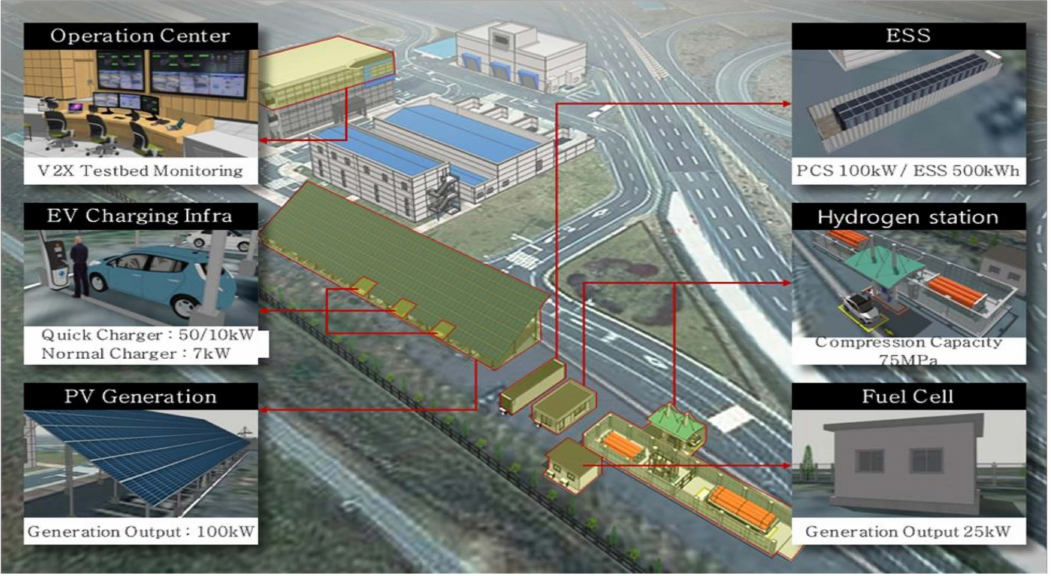
Figure 4. Vehicle to Everything (V2X) testbed diagram and